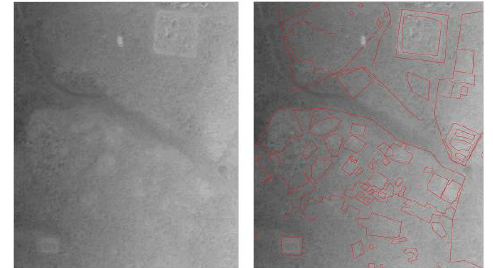
Figure 16 – A Digital Elevation Model (GSD 1m) derived from Pleiades stereoscopic image set of the Makhmúr al-Qadíma site with overlaid objects of interest on the right picture.